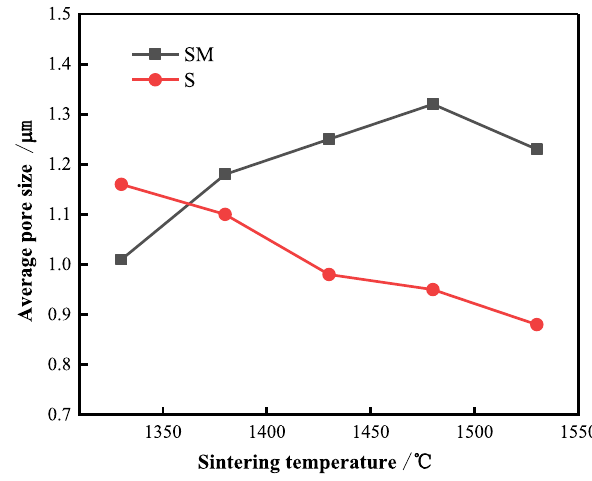
Fig. 6 The porosity of the support samples sintered at various tem- peratures in an air atmosphere for 2 h